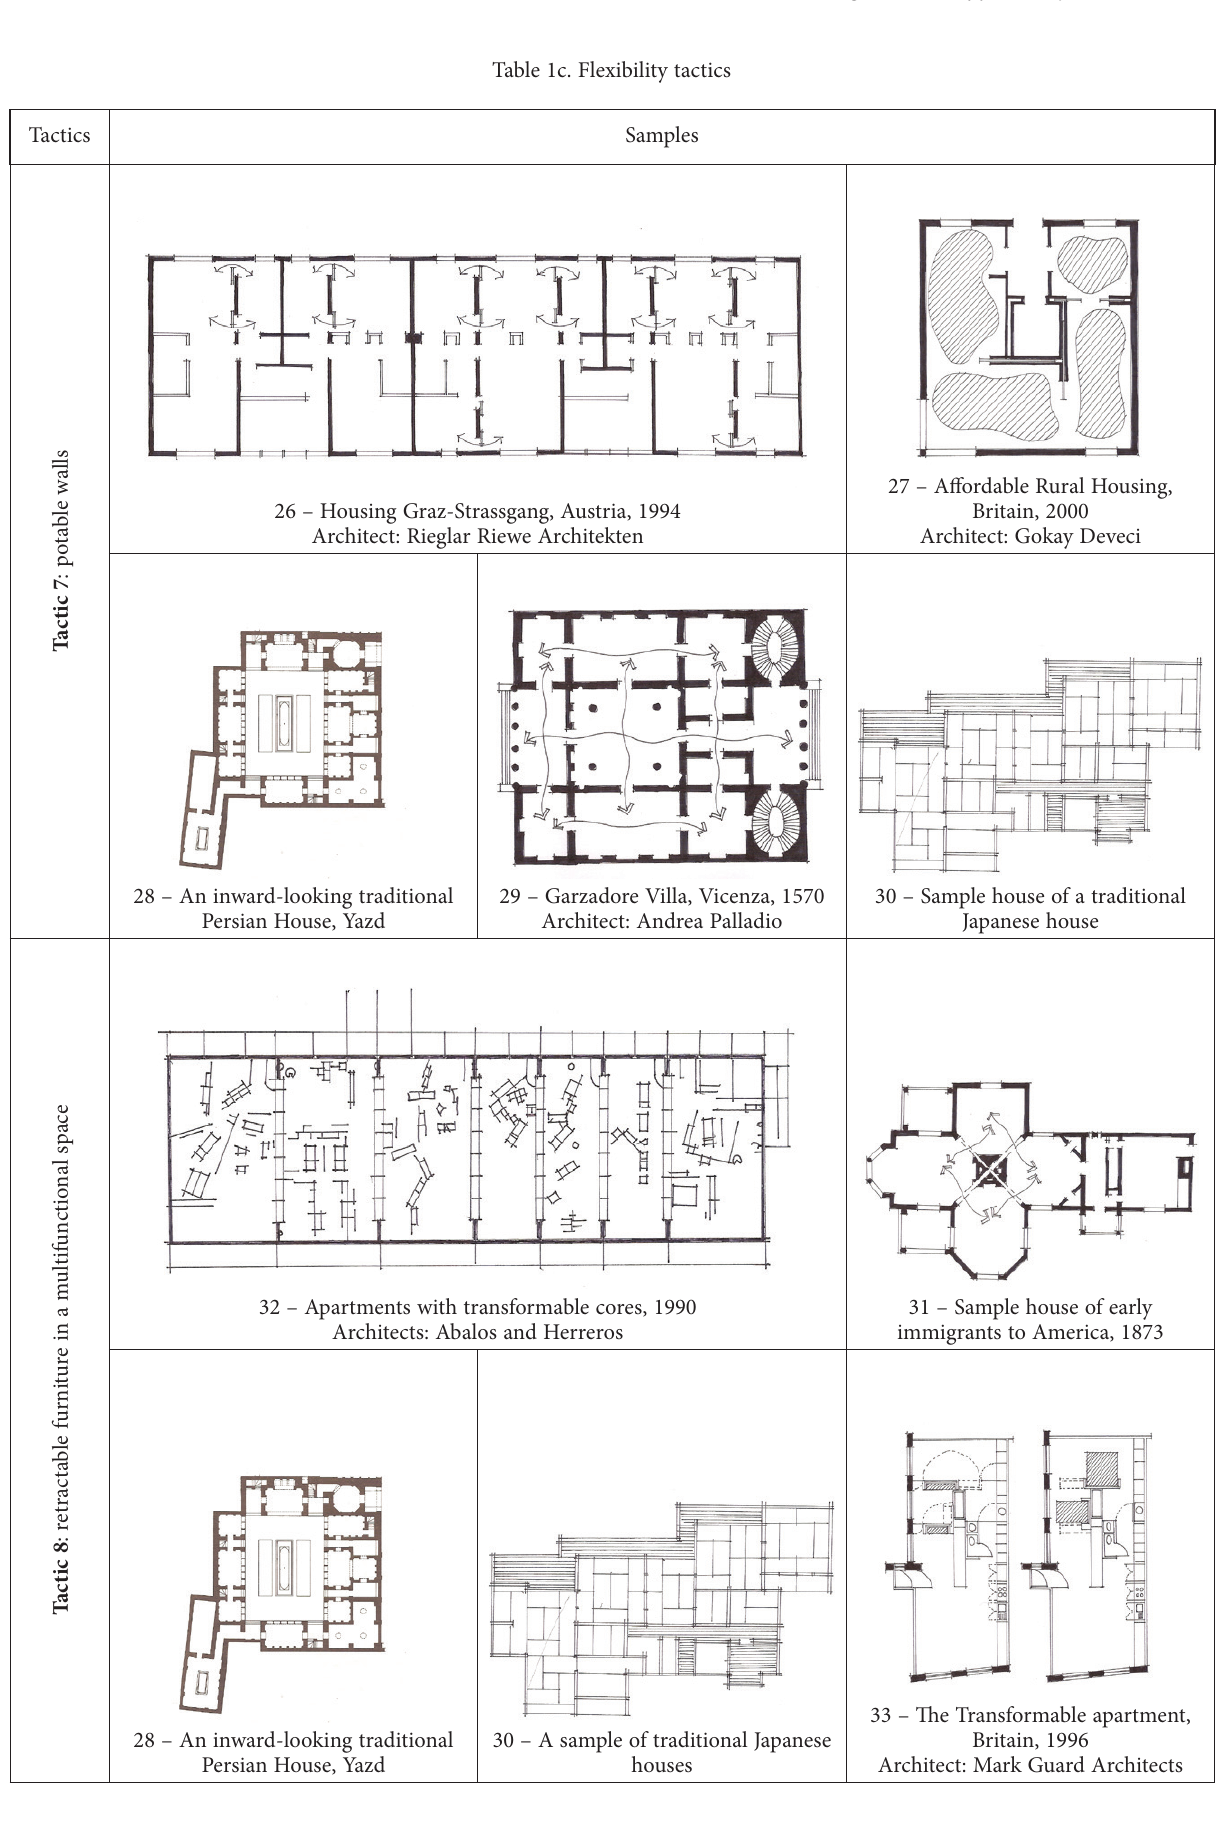
Table 1c. Flexibility